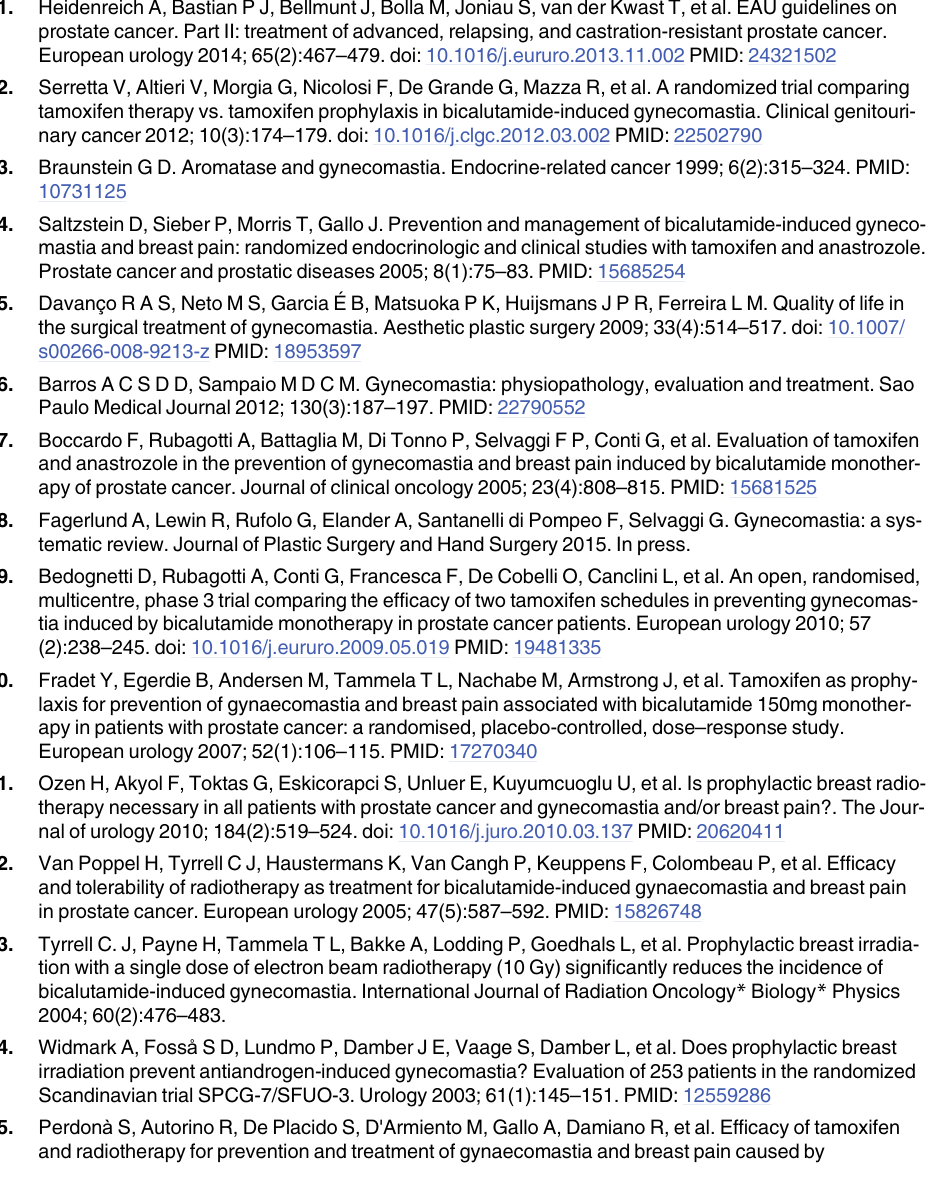
S1 Fig. Flow diagram — search process. The diagram depicts number of records identified, included and excluded as well as reasons for